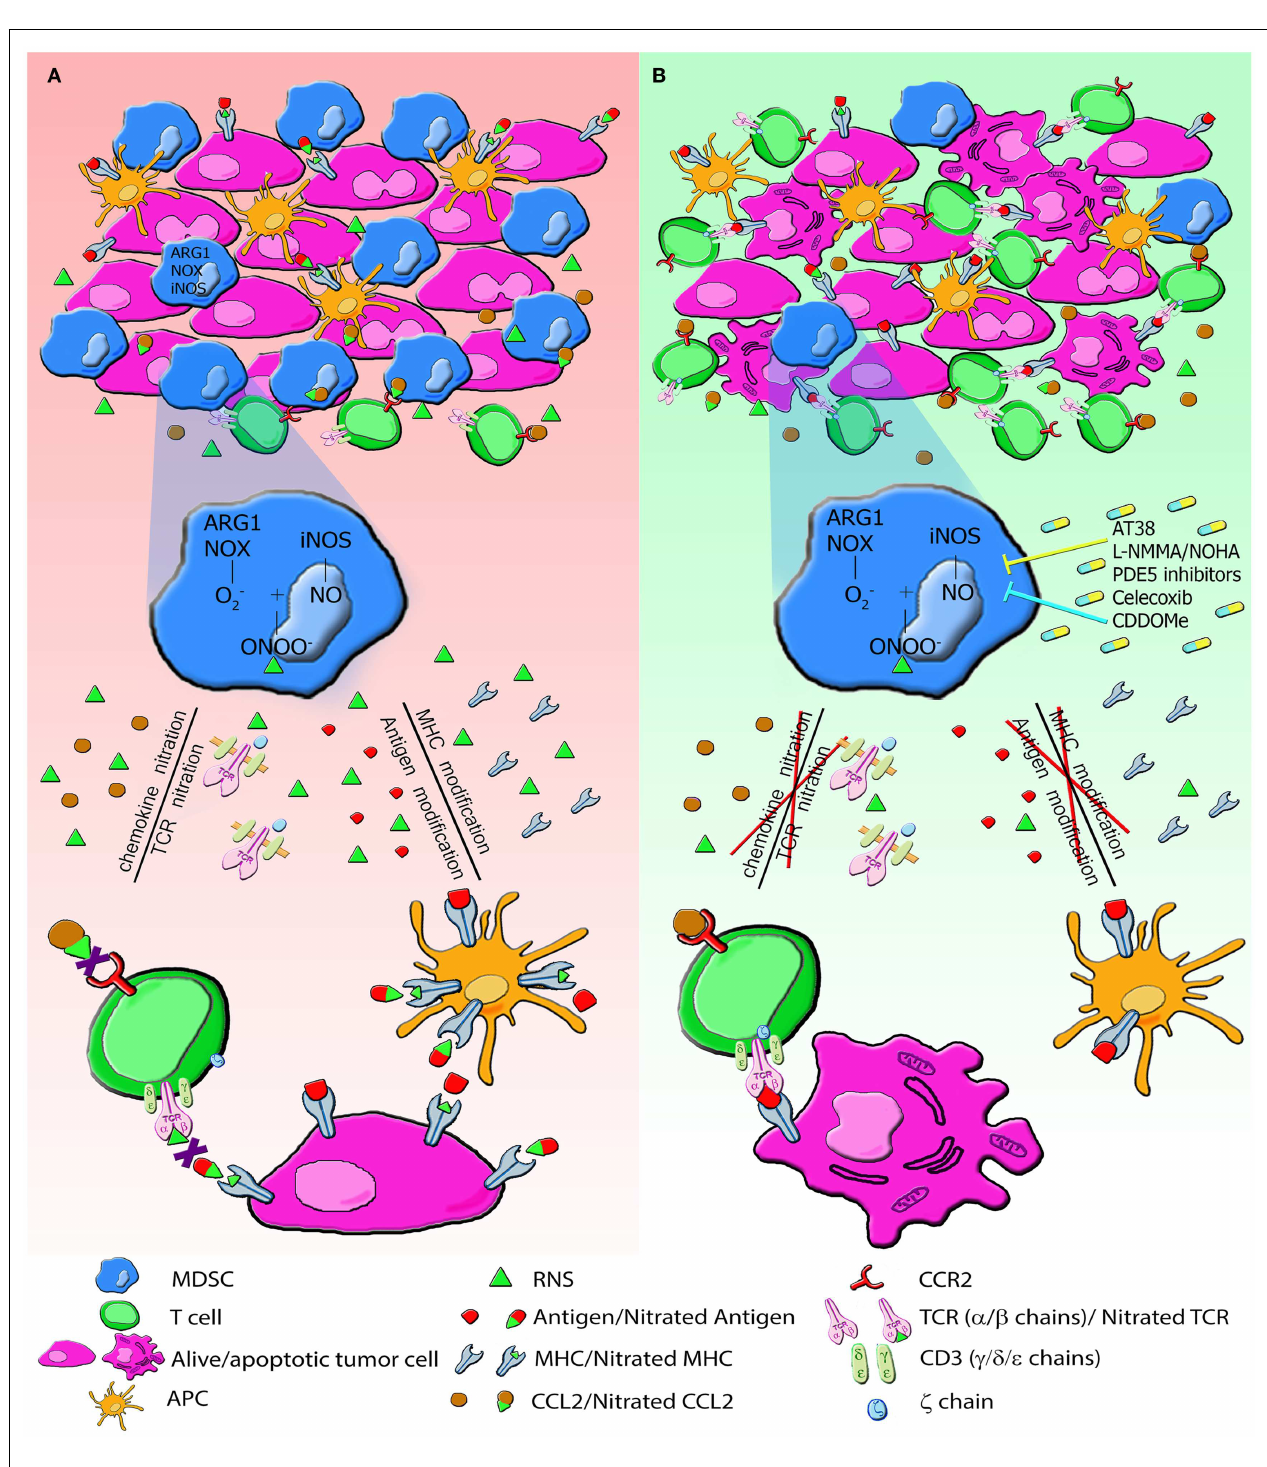
nitration reduces the binding affinity to its receptor, CCR2, drastically affecting tumor homing of CD8 + T lymphocytes. All these modifications alter the recruitment ofT cells and their cytotoxic function. (B) Administration of molecules AT38, L -NMMA, PDE5, Celecoxib, and CDDOMe through the enzymatic inhibition of NOX, ARG and NOS blocks nitration/nitrosylation, restores immune functions, and increases lymphocyte